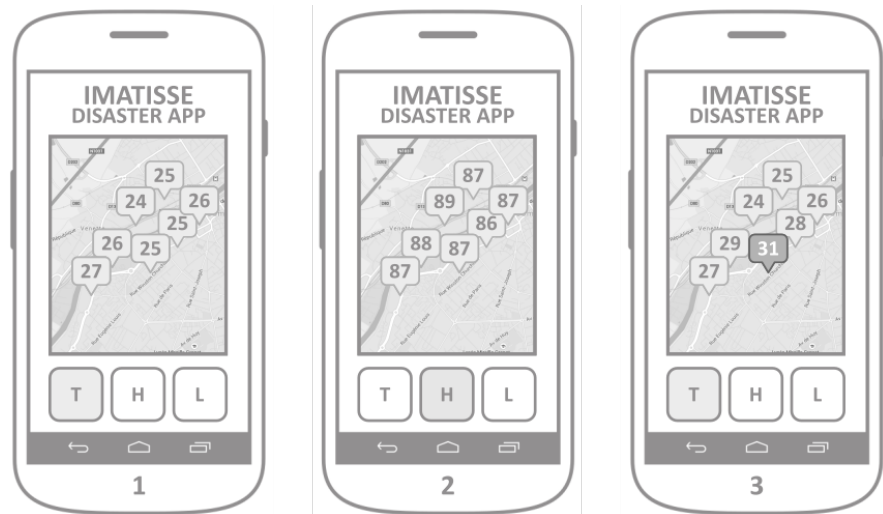
Figure 6. WSN visualization application.